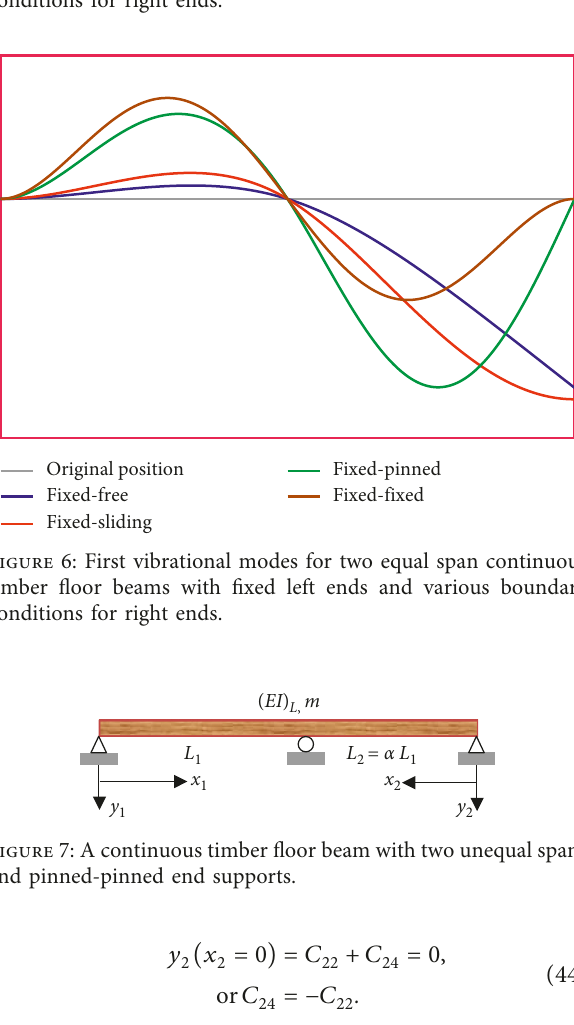
Figure 5: First vibrational modes for two equal span continuous timber floor beams with pinned left ends and various boundary conditions for right ends.